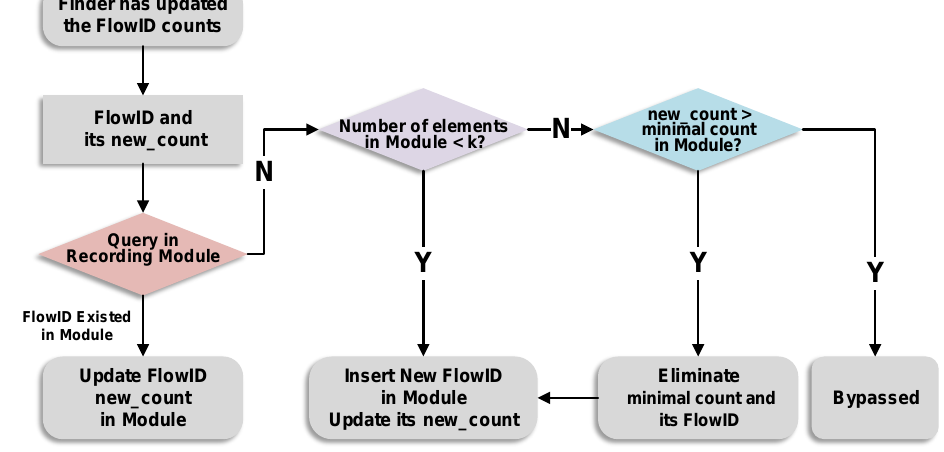
Figure 6. The structure of the flow label recording module in